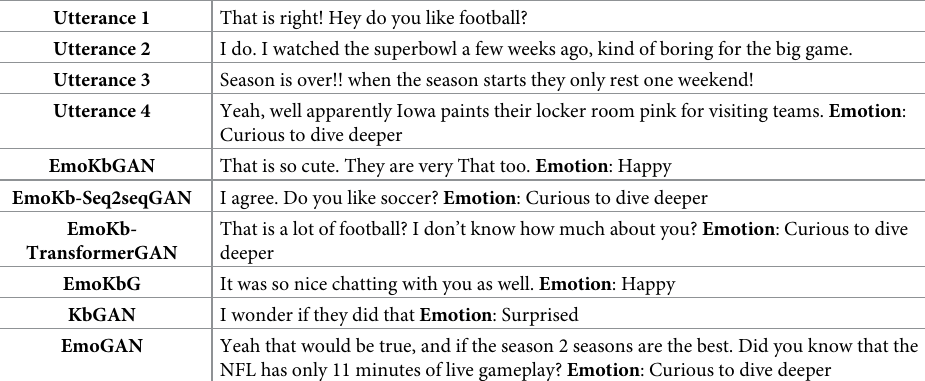
Table 9. Generated examples from our baseline, ablation and proposed models on the test set. Knowledge Base Football is a family of team sports that involve, to varying degrees, kicking a ball to score a goal. Unqualified, the word football is understood to refer to whichever form of football is the most popular in the regional context in which the word appears. Sports commonly called football in certain places include association football (known as soccer in some countries); gridiron football (specifically American football or Canadian football); Australian rules football; rugby football (either rugby league or rugby union); and Gaelic football. These different variations of football are known as football codes. the University of Iowa’s locker room for visiting football teams is completely painted pink in the 1960’s top bowlers made twice as much as top football stars—That the highest score ever in a football game occurred in 1916 when Georgia Tech defeated Cumberland 222-0 ESPN won an emmy for the creation of the superimposed yellow line representing the first down line for American football games. Former Partiots RB BenJarvus Green-Ellis has never fumbled the football in his NFL career. Sports commonly called football in certain places include association football (known as soccer in some countries); gridiron football (specifically American football or Canadian football); Australian rules football; rugby football (either rugby league or rugby union); and Gaelic football. These different variations of football are known as football codes. There are a number of references to traditional, ancient, or prehistoric ball games played by indigenous peoples in many different parts of the world. Contemporary codes of football can be traced back to the codification of these games at English public schools during the nineteenth century. By the end of the nineteenth century, distinct regional codes were already developing: Gaelic football, for example, deliberately incorporated the rules of local traditional football games in order to maintain their heritage. During the twentieth century, several of the various kinds of football grew to become some of the most popular team sports in the world.